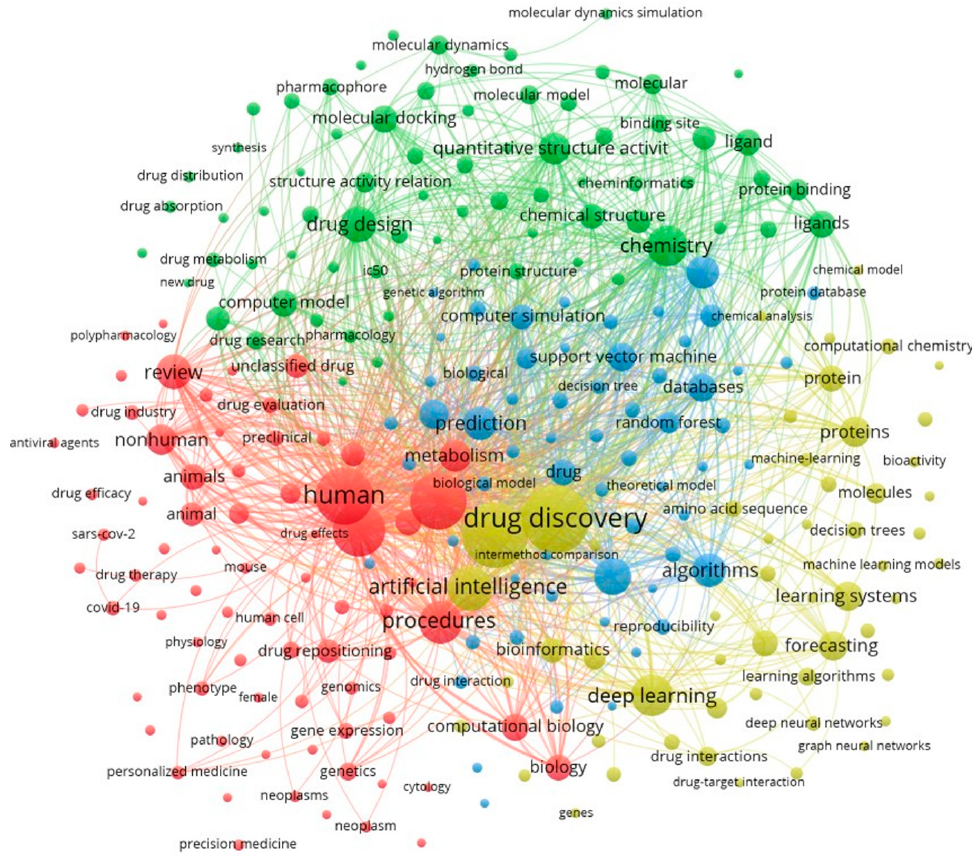
Figure 5. Keyword co-occurrence of the most-used author and indexed keywords.